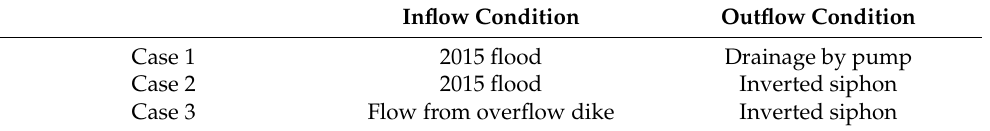
Table 3. Simulation cases.